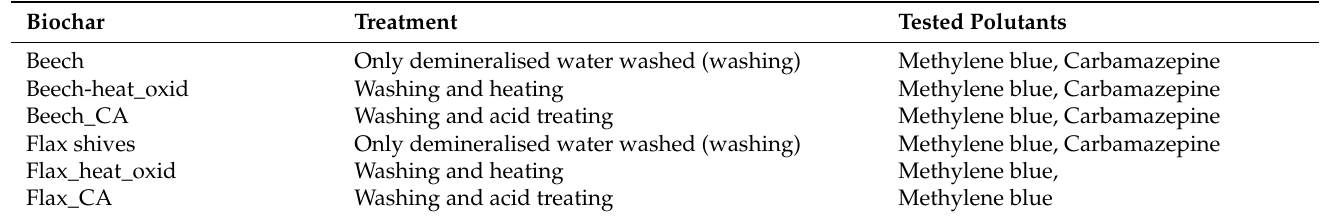
Table 2. Biochars and modified biochars used in the present work.